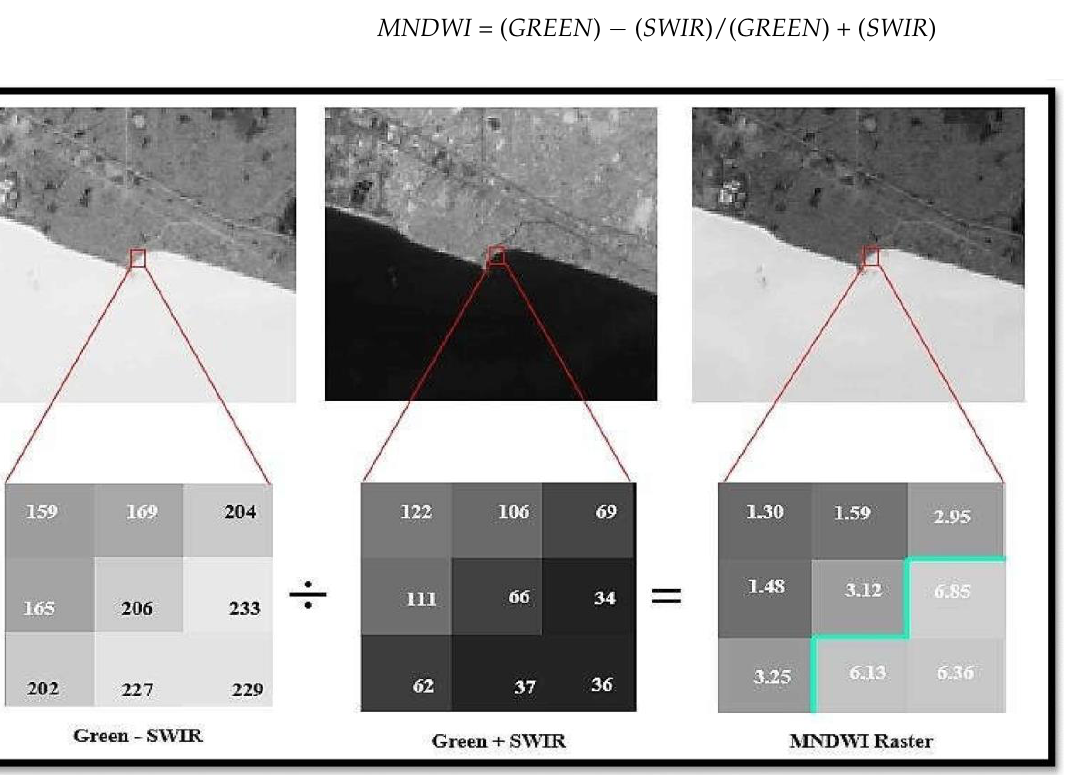
Figure 5. The classified image based on the MNDWI of the southern coast of Dakar.